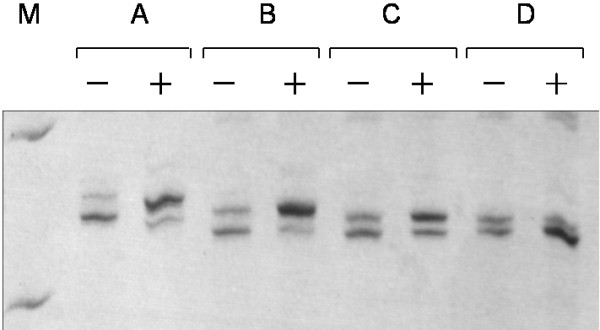
Representative data of X-chromosomal inactivation patterns in subjects, with SXCI in samples from subjects A (CR = 14, >10), B (CR = 19, >10) and C (CR = 4, >3) and without SXCI in the sample from subject D (CR = 2.1, <3). M, DNA marker, with the upper and lower bands at positions of 300 and 200 bp, respectively.